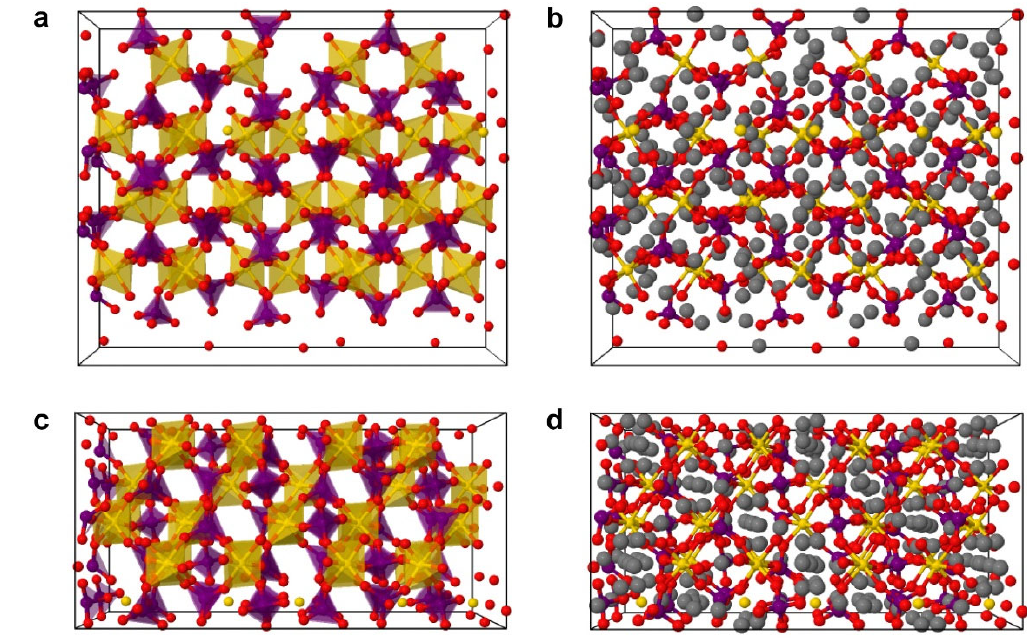
Figure 5. 3D models of the crystal structure of NASICON, displayed as top views of ( a ) linked ZrO 6 octahedra (gold) and (P/Si)O 4 tetrahedra (purple), oxygen atoms (red), and free conduction channels through the structure; ( b ) sodium ions (cyan) within the channels. ( c , d ) Corresponding front views of the lattice and the ions within the channels, respectively.